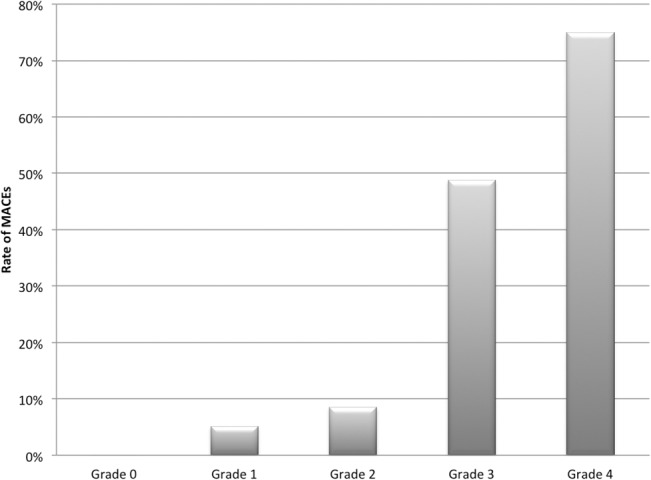
Rates of 90-day MACEs (defined as any death, resuscitated cardiac arrest, acute heart failure or stroke) were incremental with higher grades.